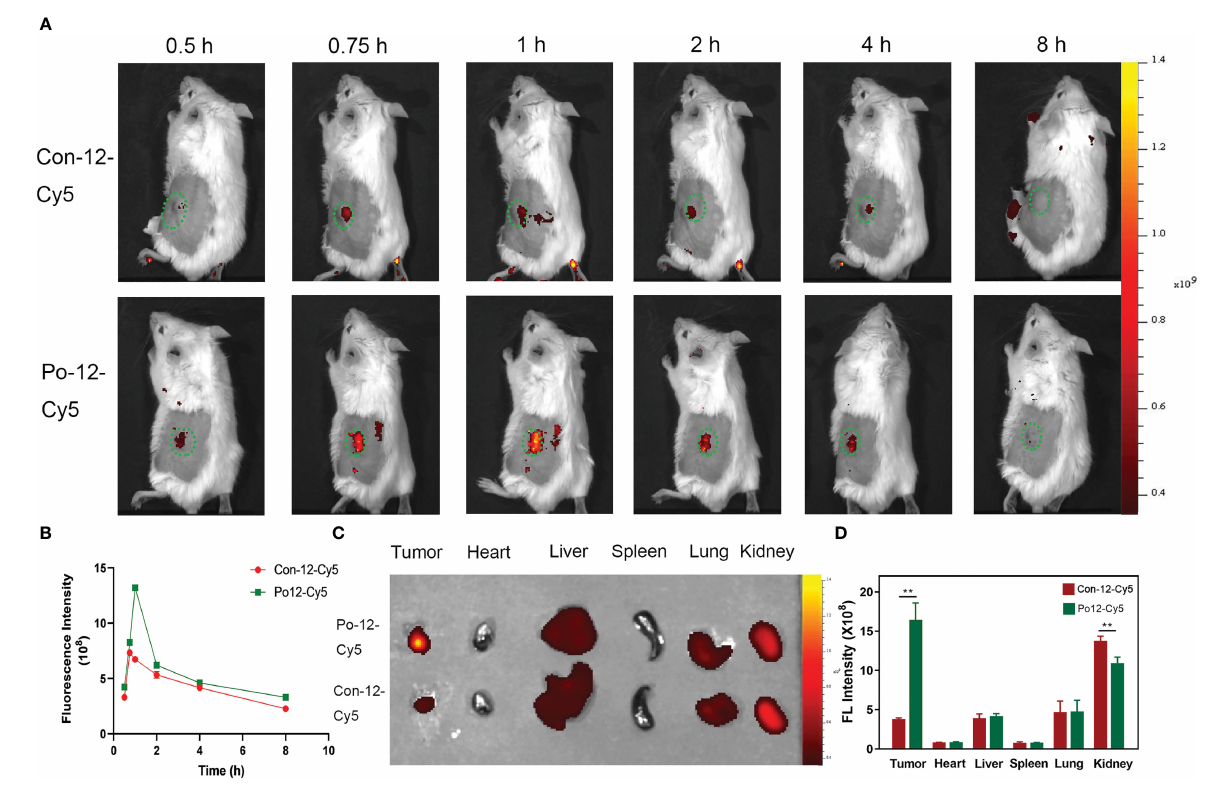
FIGURE 5 In vivo imaging of H22 subcutaneous tumors and biodistribution of the probe. (A) In vivo imaging post-injection of probes and (B) quanti fi cation of fl uorescence intensity (n=3). (C) Ex vivo imaging of tumor and normal organs (Tumor, heart, liver, spleen, lung, kidney) and (D) quanti fi cation of fl uorescence intensity (n=3). ** P <